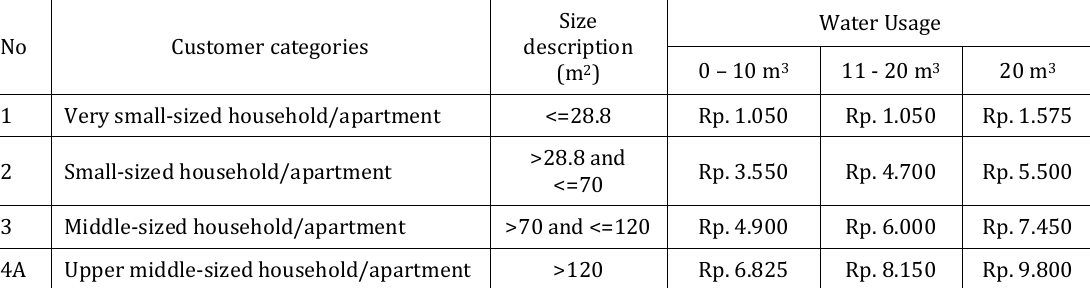
Table 2. Water tariffs in Jakarta, (Governor Office DKI Jakarta,